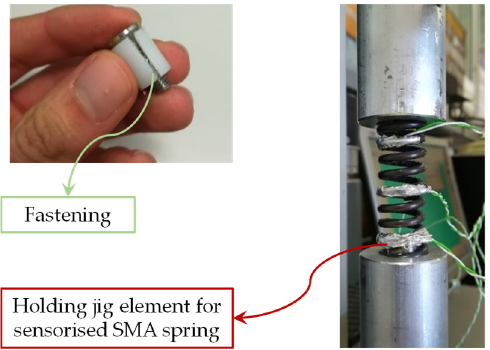
Figure 10. Fastening system for the SMA spring traction tests.